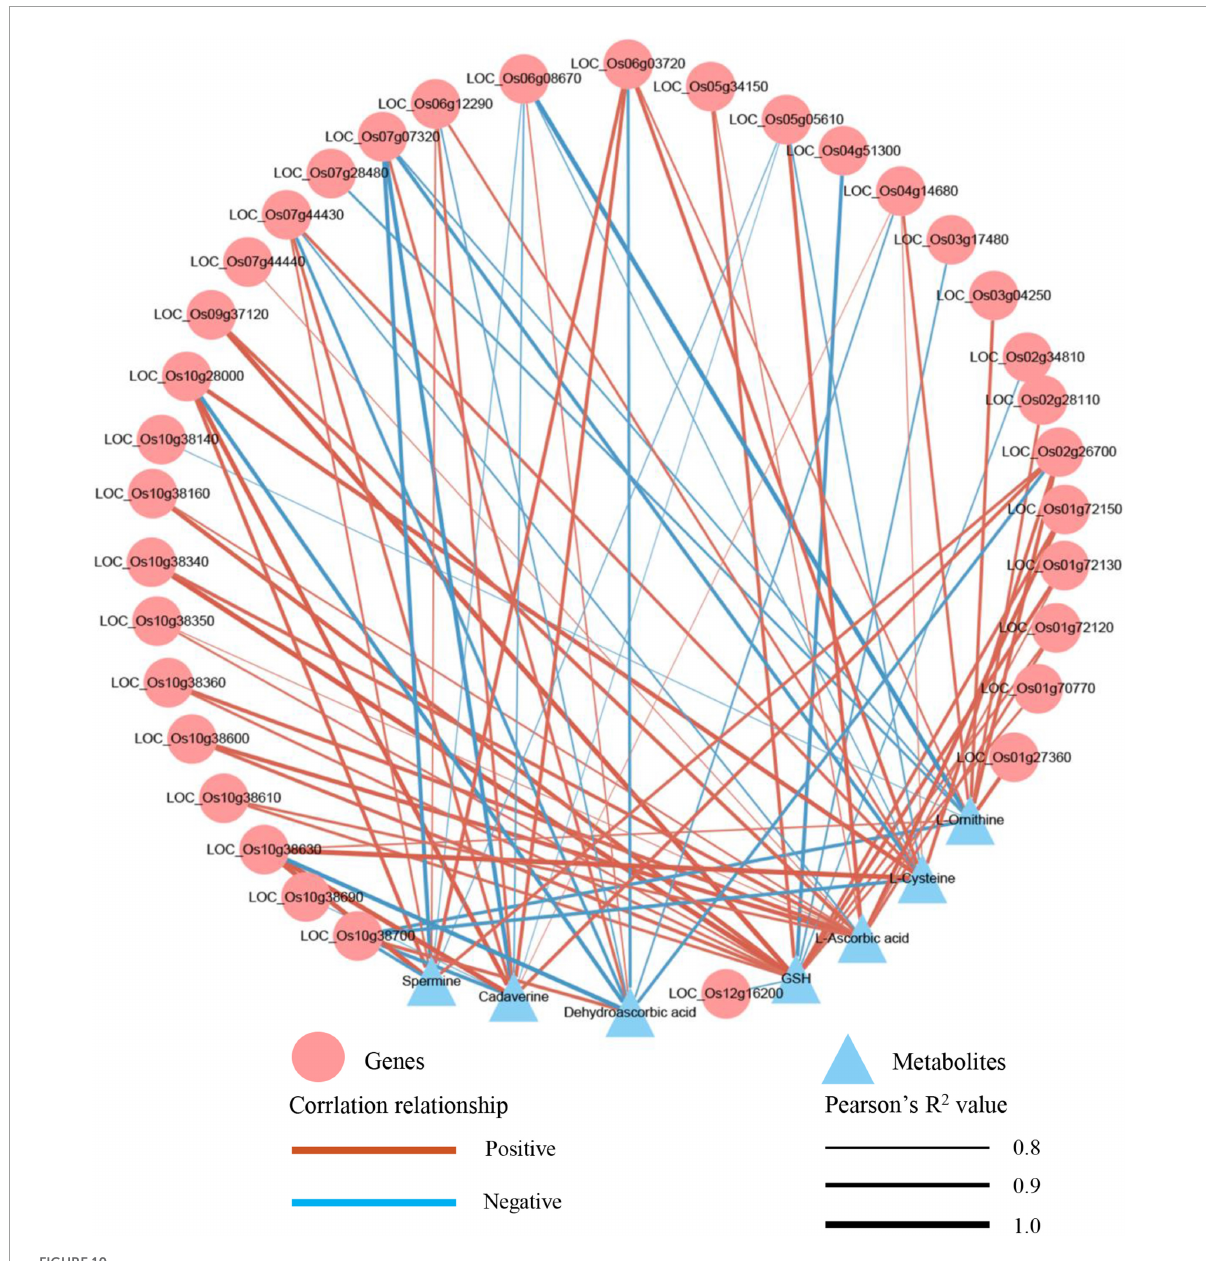
FIGURE10 Correlation network diagram of DEGs and SRMs in the